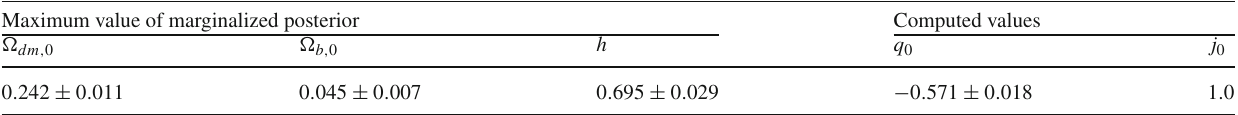
Table 3 The maximum value of marginalized posterior for each of the parameters of RVM models (left part) and the value of cosmographic parameters calculated upon maximum of the marginalized posterior (right part). We note that in model R2 we have set μ = − ν Maximum value of marginalized posterior